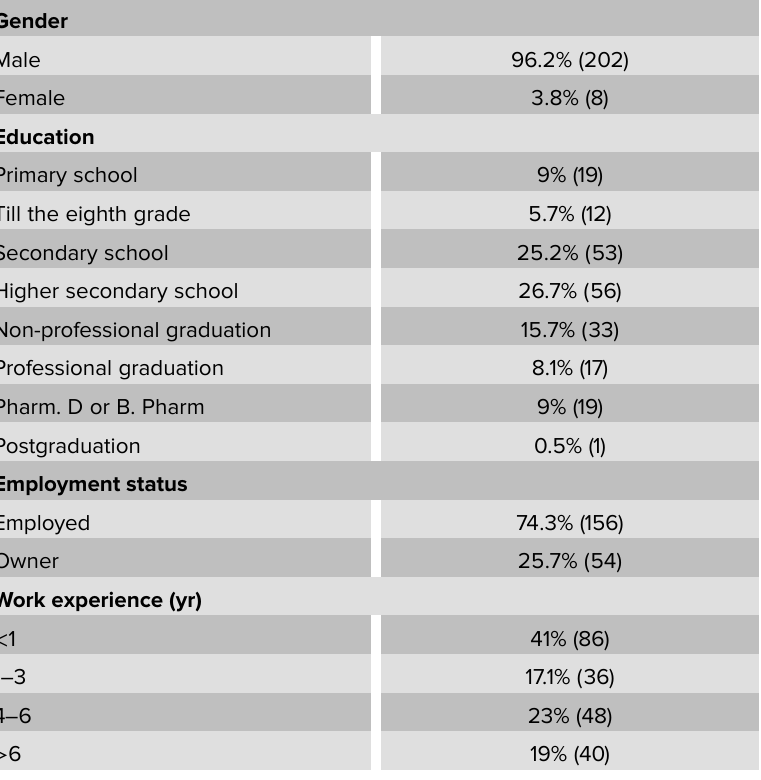
TABLE 1: Demographics of study